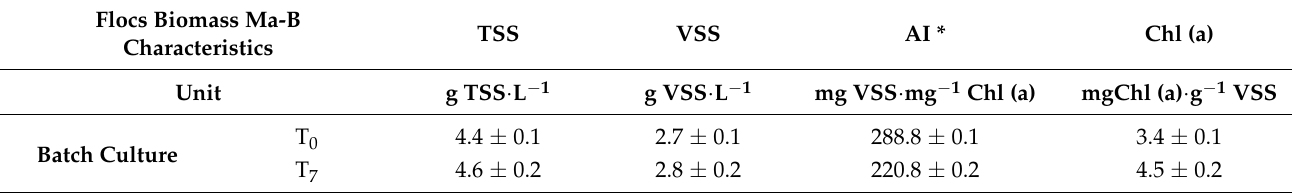
Table 1. Biomass characteristics of Ma-B flocs after batch culture.